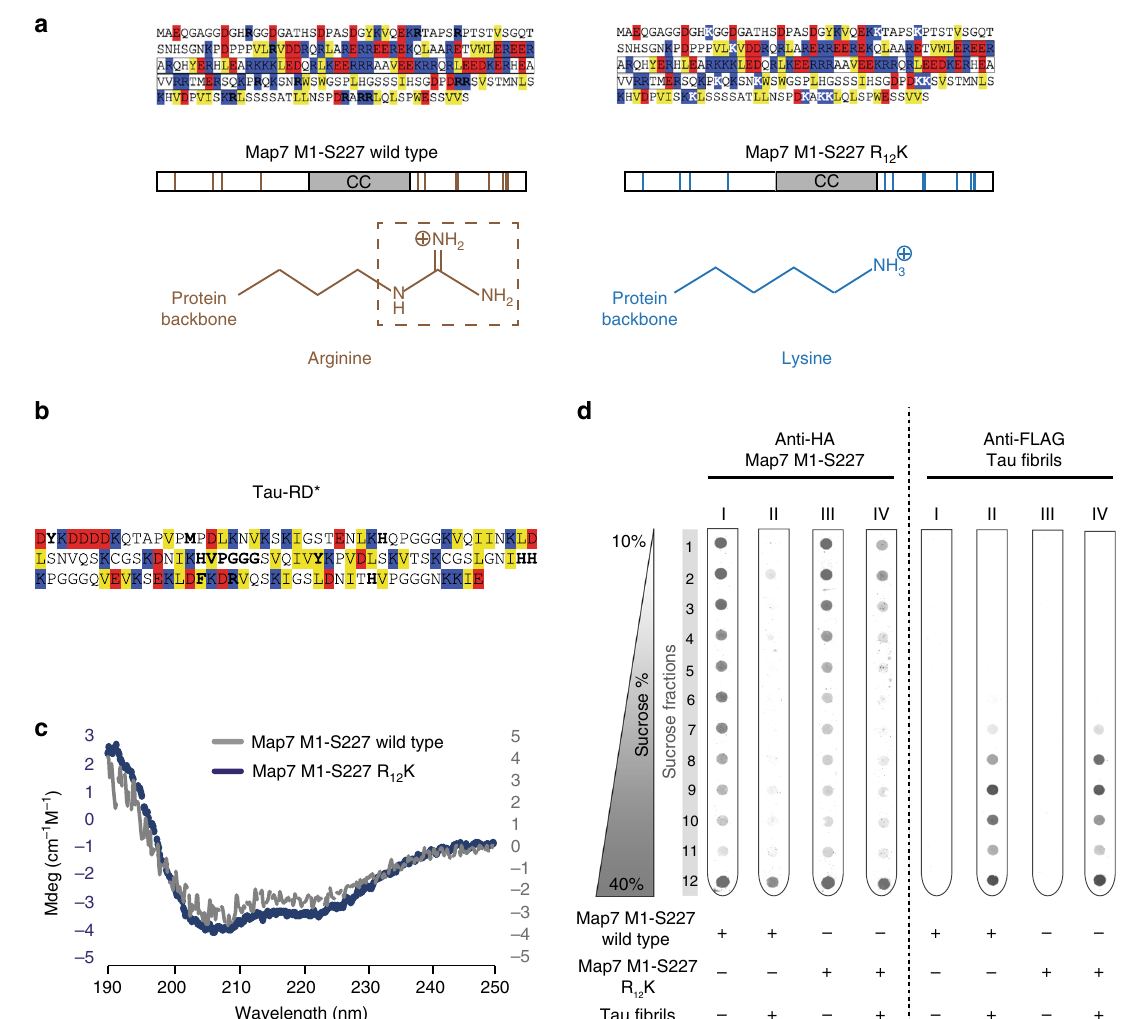
Fig. 4 π -stacking of arginines drive binding to Tau fi brils. a Graphic scheme of the two Map7 truncations used in this study. Brown and blue bars, respectively, indicate arginines and lysines in the disordered regions of the two truncations. Formulas of the two amino acids are presented, with the arginine guanidinium group (capable of π -stacking) boxed. CC = coiled-coil domain, as indicated by UniProt (access code: O88735). Sequences of Map7 M1-S227 truncations colored by hydrophobicity (yellow boxes), negative charges (red boxes), and positive charges (blue boxes) are reported on top of the cartoons; white Ks indicate arginines replaced with lysines. Boxed letters comprise the coiled-coil domain. b Tau-RD* sequence, colored as in a . Bold letters represent potential π -stacking sites, including the VPGGG motif 32,50 . c Circular dichroism of Map7 M1-S227 truncations. d Binding of Map7 1M-227S truncations to Tau-RD* fi brils, assessed by density gradients. Tubes (I – IV) were either blotted against HA tag or against FLAG tag, targeting respectively Map7 truncations or Tau-RD* fi brils. Samples were centrifuged for 2.5 h at 200,000× g